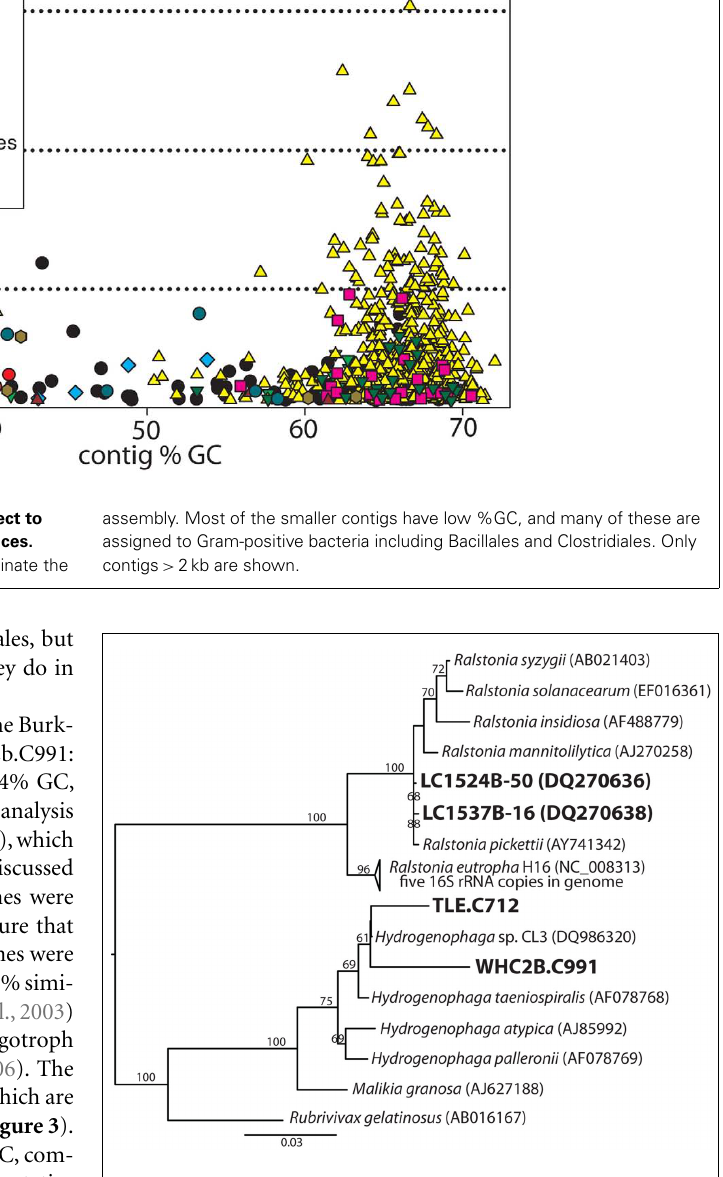
FIGURE 3 | Phylogenetic tree of Burkholderiales 16S rRNA sequences including two 16S rDNA clones from Lost City carbonate chimneys and a partial 16S rRNA coding sequence identified in a metagenomic contig from theTablelands fluid